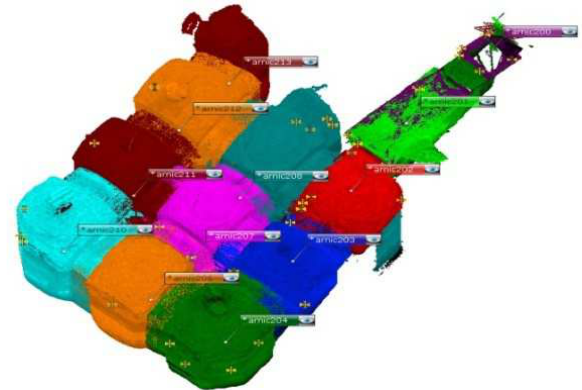
Figure 5. Scanning plan of the cistern The scanning has been realized from fifteen stations. Ten of them were inside stations and used to scan walls and ten domes, three of them were at the entrance and last five stations were used to scan stairs. The cistern has ten domes therefore the scanning process was made from ten stations. By using ground control points which have been placed on the exterior walls of the cistern, point clouds have been registered to the ground coordinate system. The scanning distance was 10 meters; the footprint size had a 3 mm diameter. The modelling result is given in Figure 6.